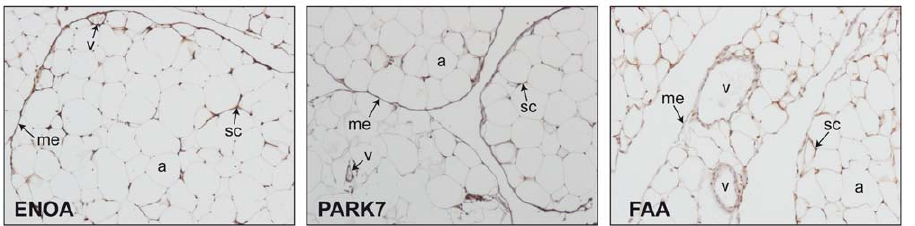
Figure 5. Immunohistochemical detection of ENOA, PARK7 and FAA in omental adipose tissue. Images are representative of adipose tissue sections collected from five subjects. Magnification 6 100. a , adipocyte; me , mesothelium; sc , stromal cells; v ,